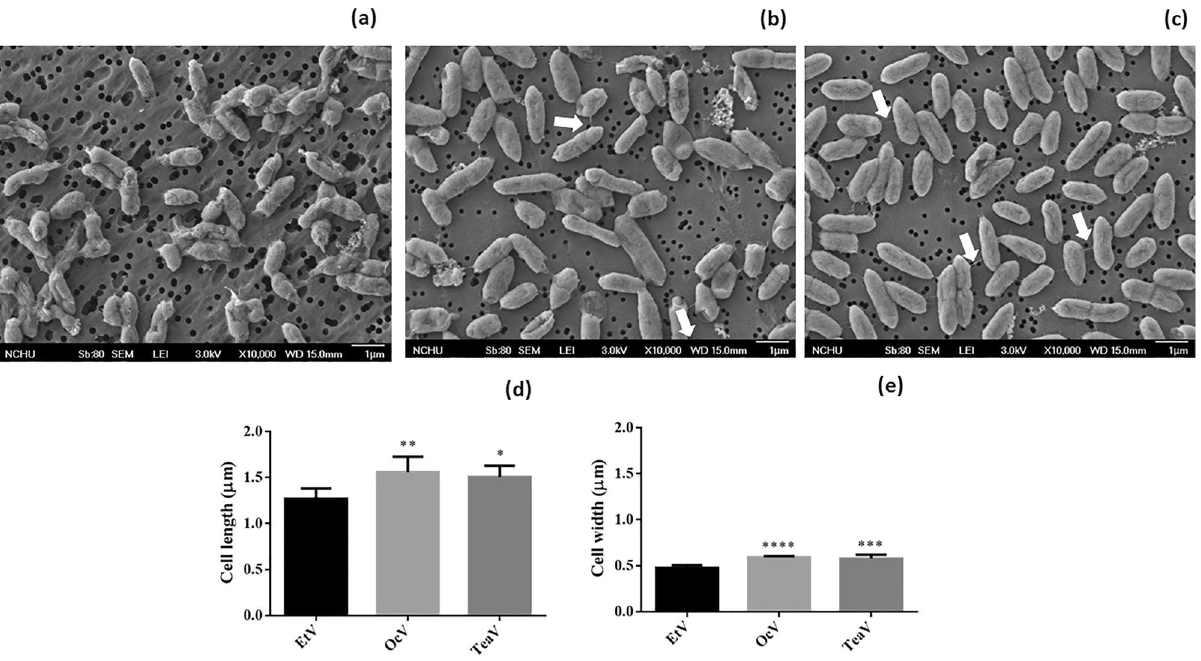
Figure 4. Influence of the vapors of ethanol (EtV), 1-octanol (OcV) and aqueous tea extracts (TeaV) on cell morphology of Pseudomonas sp. NEEL19, cultured in DSMZ 125* containing 0.1% (w/v) Trp. Scanning electron micrographs of cells originated from ( a ) EtV, ( b ) OcV and ( c ) TeaV treatments are shown. ( d ) and ( e ) show variations in cell length and width, respectively; Sample exposed to EtV was used as a control. Arrow, putative pili/nanowire; Error bar, mean (n = 60) ± s.d. * P < 0.1, ** P < 0.05, *** P < 0.01, **** P < 0.0001; ns, non-significant.